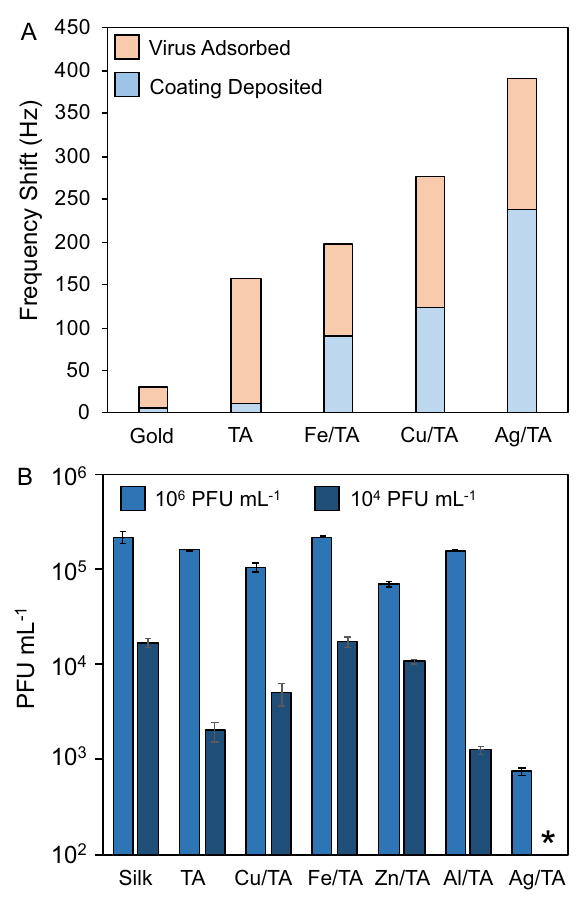
Figure 2. Metal/TA coatings and their ability to interact with and neutralize viruses (phi6). ( A ) Frequency shift (1st overtone) and associated mass of coatings deposited using TA by itself and with different metals and their subsequent ability to interact with viruses as monitored by QCM. ( B ) Antiviral properties of coatings on silk made from TA by itself and with different metals at different virus concentrations. Note that no virus was detectable at the lowest concentration (10 4 PFU mL −1 ) when incubated with Ag/TA (marked with *), where 10 2 PFU mL −1 was the minimum detectable concentration of the